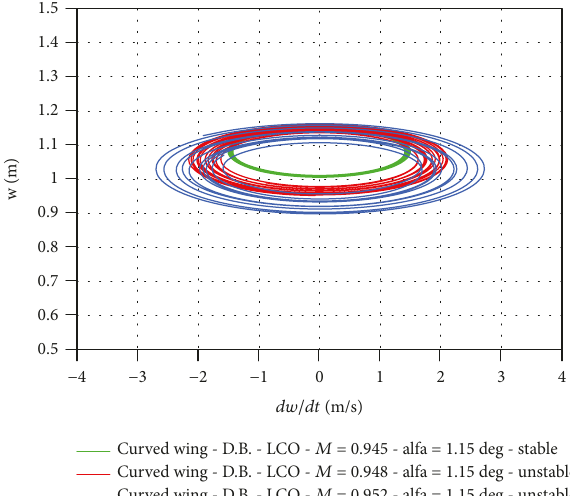
Figure 32: FSI analysis — estimation of lift coe ffi cient LCOs (Case 2) — density